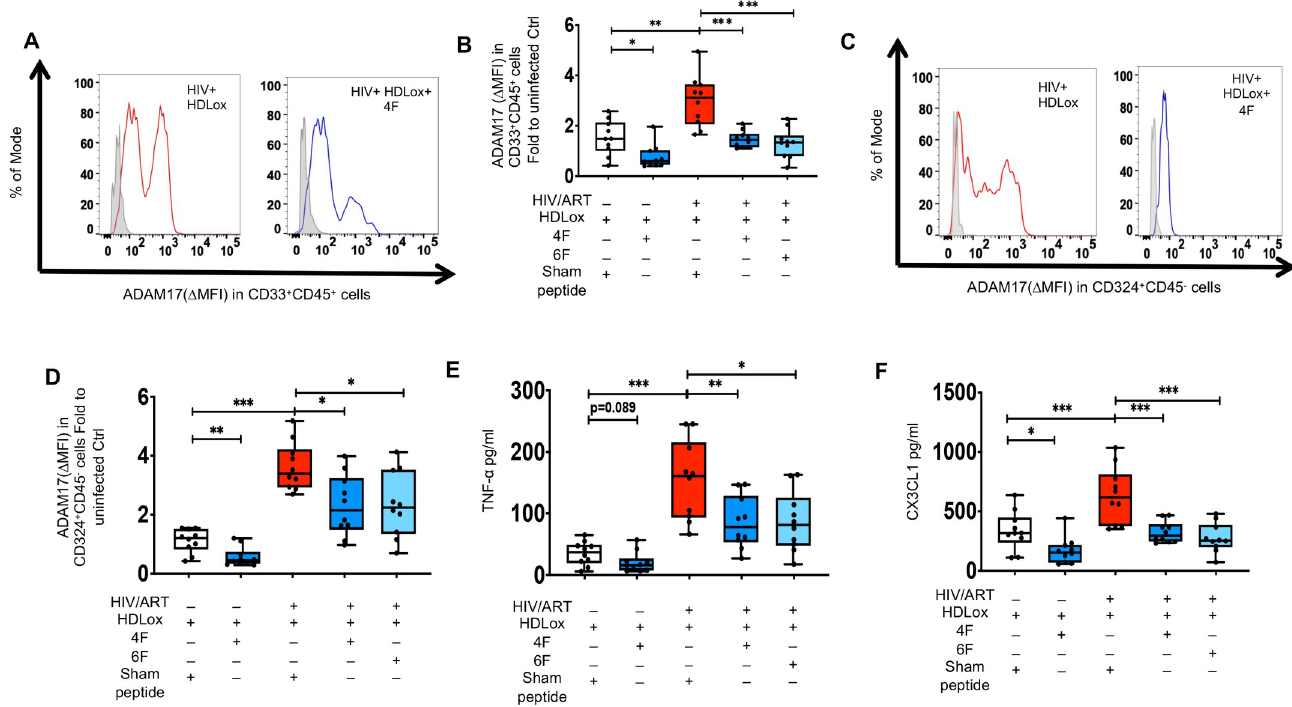
Fig 6. Ex vivo impact of ApoA-I mimetic peptides and oxidized high density lipoprotein (HDLox) on proteins levels of ADAM17 and associated cytokines and chemokines in gut explants of uninfected and HIV infected participants. Gut biopsies were obtained from uninfected (n = 10) and HIV infected participants on potent antiretroviral therapy (ART) (n = 10) and gut explants were treated with HDLox for 48 hours and 4F or 6F apoA-I mimetic peptides or sham peptide for 72 hours as in Materials and Methods. Gut biopsies from the same participants were used for experiments with treatments. A-D. Protein levels of A disintegrin and metalloprotease 17 (ADAM17) was detected in myeloid CD33 + CD45 + (A, B ) and CD324 + CD45 - epithelial cells (C, D ) isolated from gut biopsies obtained from uninfected and HIV infected participants treated as shown. A, C . Representative data of flow cytometry data of protein levels (Median fluorescence intensity) of ADAM17 are shown for myeloid CD33 + CD45 + . (A ) and CD324 + CD45 - epithelial cells (C ). Δ MFI represents a shift in median fluorescence intensity of a positive cell population compared to a negative cell population within each sample. The negative cell population was defined based on a fluorescence minus one negative control for staining as shown in light filled grey histogram. B, D. Summary data for protein levels of ADAM17 in intestinal myeloid CD33 + CD45 + ( B ) and CD324 + CD45 - epithelial cells ( D ) from gut biopsies treated as shown. E, F. Supernatants were collected at 72 hours and Luminex immunoassays were used to determine protein levels of cytokines [tumor necrosis factor alpha (TNF- α )]( E) and chemokines [C-X3-C Motif Chemokine Ligand 1 (CX3CL1)] ( F) , that are mediated by ADAM17 sheddase activity. Data represent box and whiskers with minimum, median and maximum values. Datapoints represent mean of 3 gut biopsies per participant. The Mann-Whitney test was used to compare 2 groups ( � p < 0.05, �� p < 0.01, ��� p < 0.001). LDLox in HIV + ART + TKO BLT mice (S1 Table). Protein cellular levels of ADAM17 did not correlate with plasma HDLox, in HIV + ART + Tg6F + TKO BLT mice (S1 Table), consistent with our prior data that Tg6F is an intervention that reduces HDLox [24]. Gut explants of HIV + and uninfected participants treated with HDLox (Fig 6) had higher intestinal protein levels of ADAM17 in myeloid CD33 + CD45 + (Fig 6A and 6B) and CD324 + CD45 - epithelial cells (Fig 6C and 6D) and intestinal TNF- α (Fig 6E) and CX3CL1 (Fig 6F) compared to vehicle controls (Fig 4A, 4B, 4C, 4D, 4E and 4F). Gut explants of HIV + and uninfected participants treated with LDLox (Fig 7) had also higher intestinal protein levels of ADAM17 in myeloid CD33 + CD45 + (Fig 7A and 7B) and CD324 + CD45 - epithelial cells (Fig 7C and 7D) and intesti- nal TNF- α (Fig 7E) and CX3CL1 (Fig 7F) compared to vehicle controls (Fig 7A, 7B, 7C, 7D, 7E and 7F). Both 4F and 6F reduced ADAM17 in myeloid cells (Fig 6A and 6B) and epithelial cells (Fig 6C and 6D) and secretion of CX3CL1 (Fig 6F) from HDLox-treated gut explants from both uninfected and HIV + participants. 4F tended (p = 0.089) to reduce secretion of TNF- α from HDLox-treated gut explants from uninfected participants (Fig 6E). 4F and 6F reduced secretion of TNF- α from HDLox-treated gut explants from HIV + participants (Fig